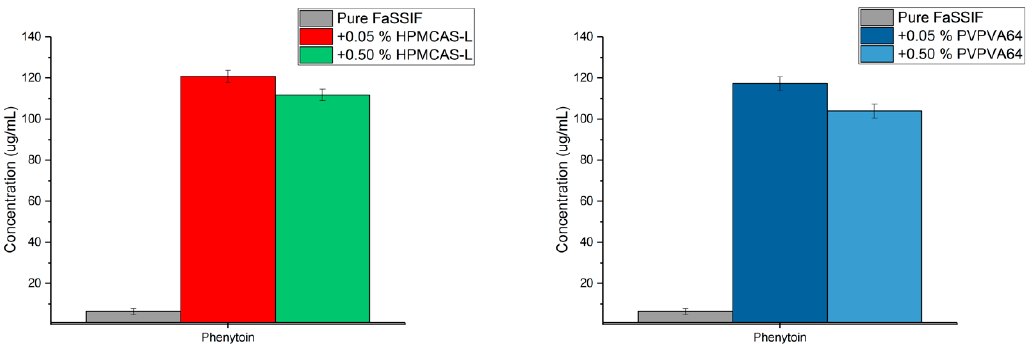
Figure 3. Maximum achievable concentration of phenytoin in fasted state simulated intestinal fluid (FaSSIF) and in FaSSIF in the presence of hypromellose acetate succinate L-grade (HPMCAS-L) ( left ) or vinylpyrrolidine-vinyl acetate copolymer (PVPVA64) ( right ) using the solvent shift method SSPM [23].